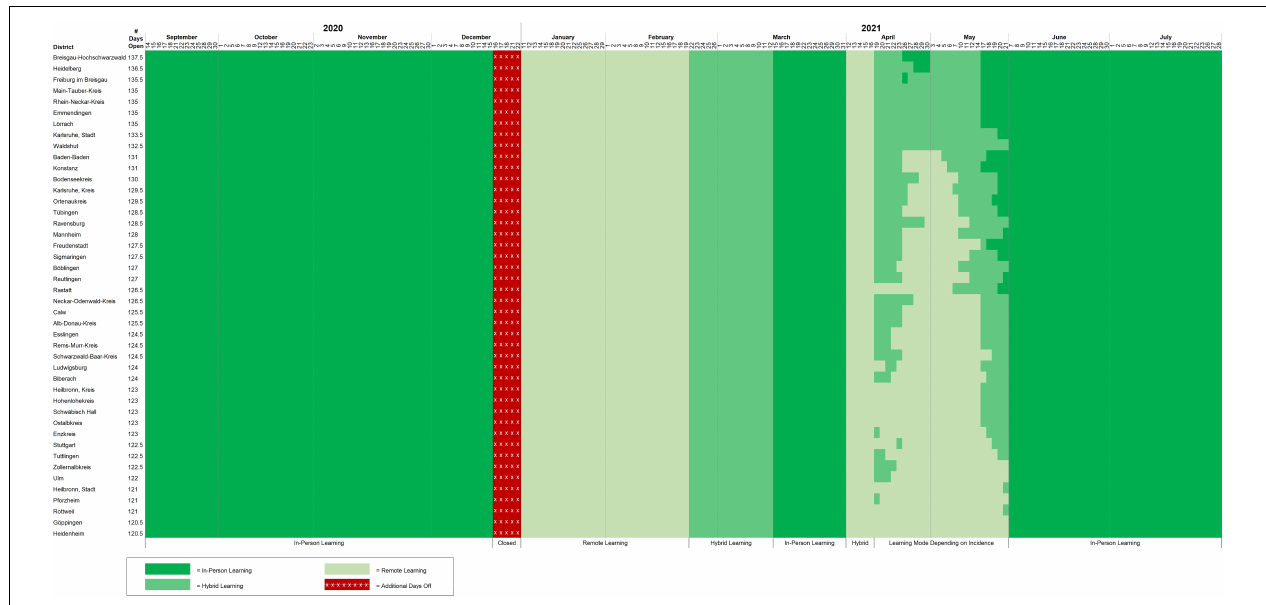
FIGURE 1 | Learning Modes for Each School Day (columns) During the School Year 2020/21 for Grade 4 According to Regulations and Local Incidence Rates in Each of Baden-Württemberg’s 44 Districts